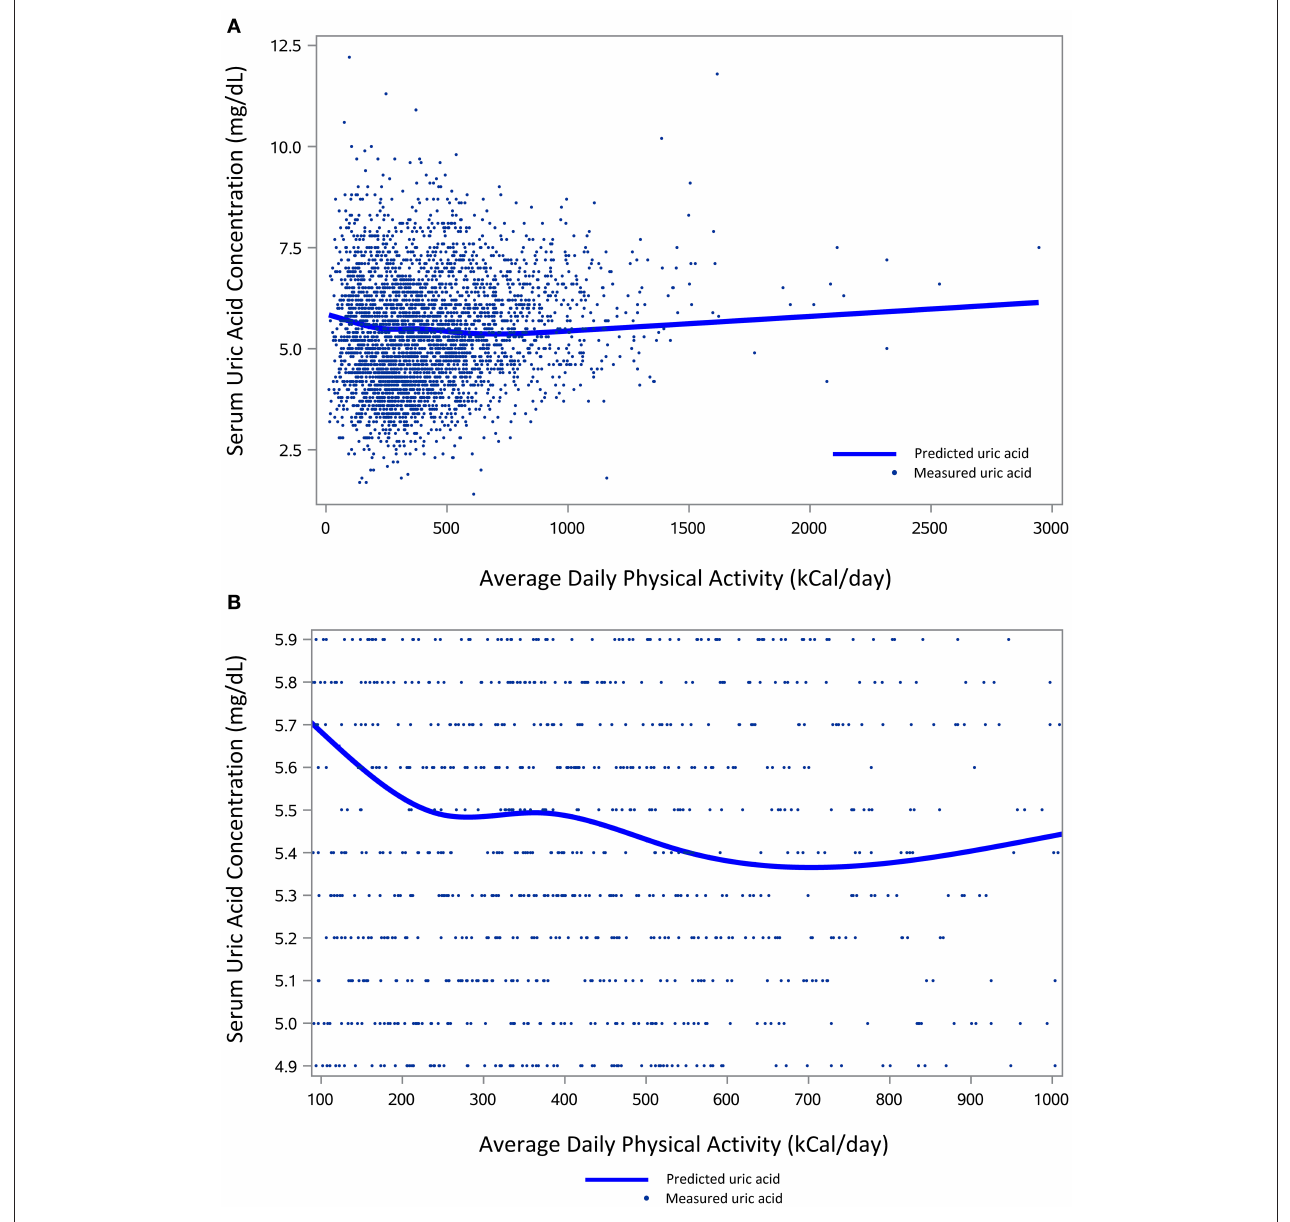
FIGURE 1 | The relation of physical activity and serum uric acid concentrations. (A) Depicts measured and predicted uric acid concentrations (mg/dL) across the entire range of average daily physical activity (kCal/day). (B) Shows a more focused view of predicted uric acid concentrations for the middle 95% of the population (median ± 47.5%) based on average daily physical activity. Predicted uric acid levels for both figures are based on the same multivariable analysis, adjusted for age, gender, race/ethnicity, alcohol use, Body Mass Index, serum creatinine, and use of urate-lowering